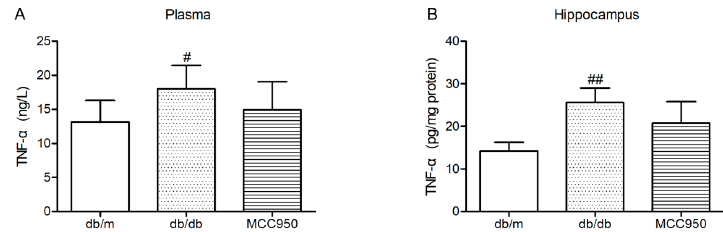
Figure 7. Effect of MCC950 on tumor necrosis factor- α (TNF- α ) in the plasma and hippocampus of db/db mice. ( A ) Levels of TNF- α in the plasma samples of mice ( n = 8 mice/group); ( B ) Levels of TNF- α in the hippocampus samples of mice ( n = 3 mice/group). All data are represented as mean ± SD. ## p < 0.01, # p < 0.05, compared with the db/m-group.